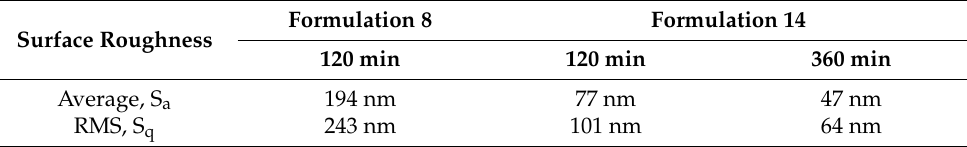
Figure 8. SEM images of fabricated coatings after immersion in formulation 14 (IPA, 2% wt. 1 M NaOH (aq), 0.2 M stearic acid and nano-SiO 2 ) for ( a ) 120 min and ( b ) 360 min. Table 2. Surface roughness data via AFM from samples coated in formulation 8 and